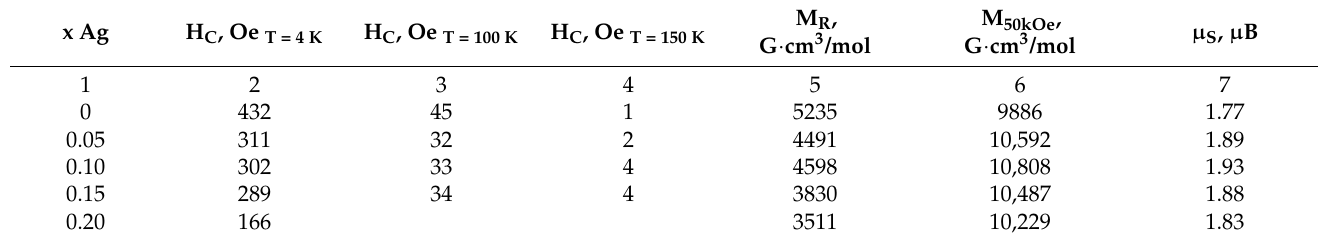
Table 2. Characteristics of hysteresis loops of Fe 1 − x Ag x Cr 2 S 4 solid solutions at different